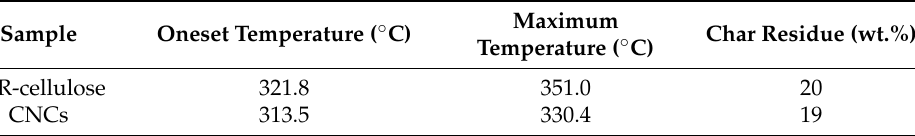
Figure 5. ( a ) TG and ( b ) DTG curves of PSR-cellulose and CNCs. Table 6. Thermal behavior of PSR-cellulose and CNCs.